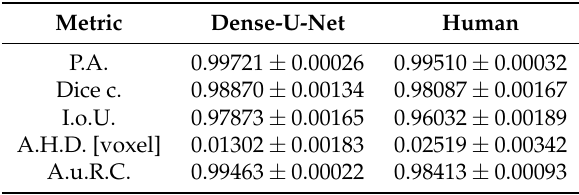
Table 5. Fine-tuned model trained using 3-folds cross-validation, results includes standard deviation. Used neural network is Dense-U-Net network. Achieved results are compared to another human expert results. For evaluation, several metrics were used: pixel accuracy, Dice coefficient, intersection over union, average Hausdorff distance [voxel] and area under ROC